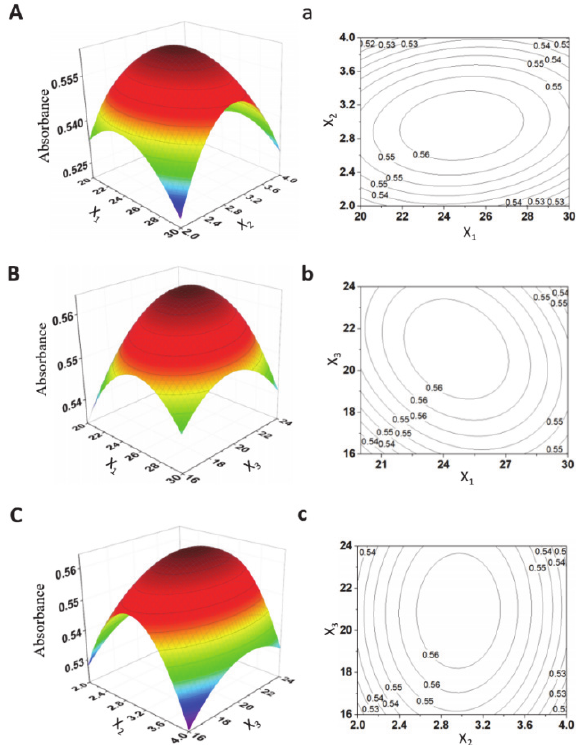
Figure 1. Response surface plots showing effects of variables on the iron content of LRPF. ( A , a ) Plots of the effect of reaction pH, mass ratio of trisodium citrate to LRP and their interaction. ( B , b ) Plots of the effect of reaction pH, reaction time and their interaction. ( C , c ) Plots of the effect of mass ratio of trisodium citrate to LRP, reaction time and their interaction.